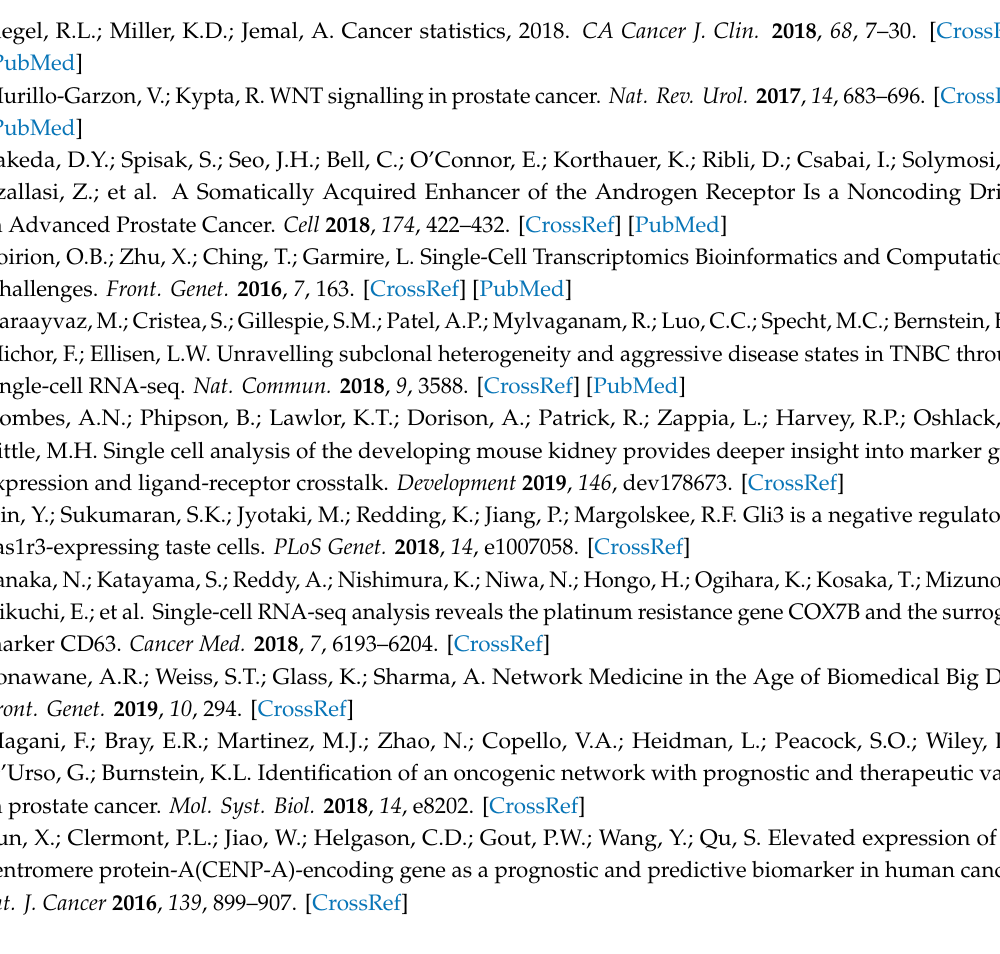
Figure S1: Parameters used to determine the threshold (power value), Figure S2: Survival analysis for FECH and CROT, Table S1: Rank functional terms using R package